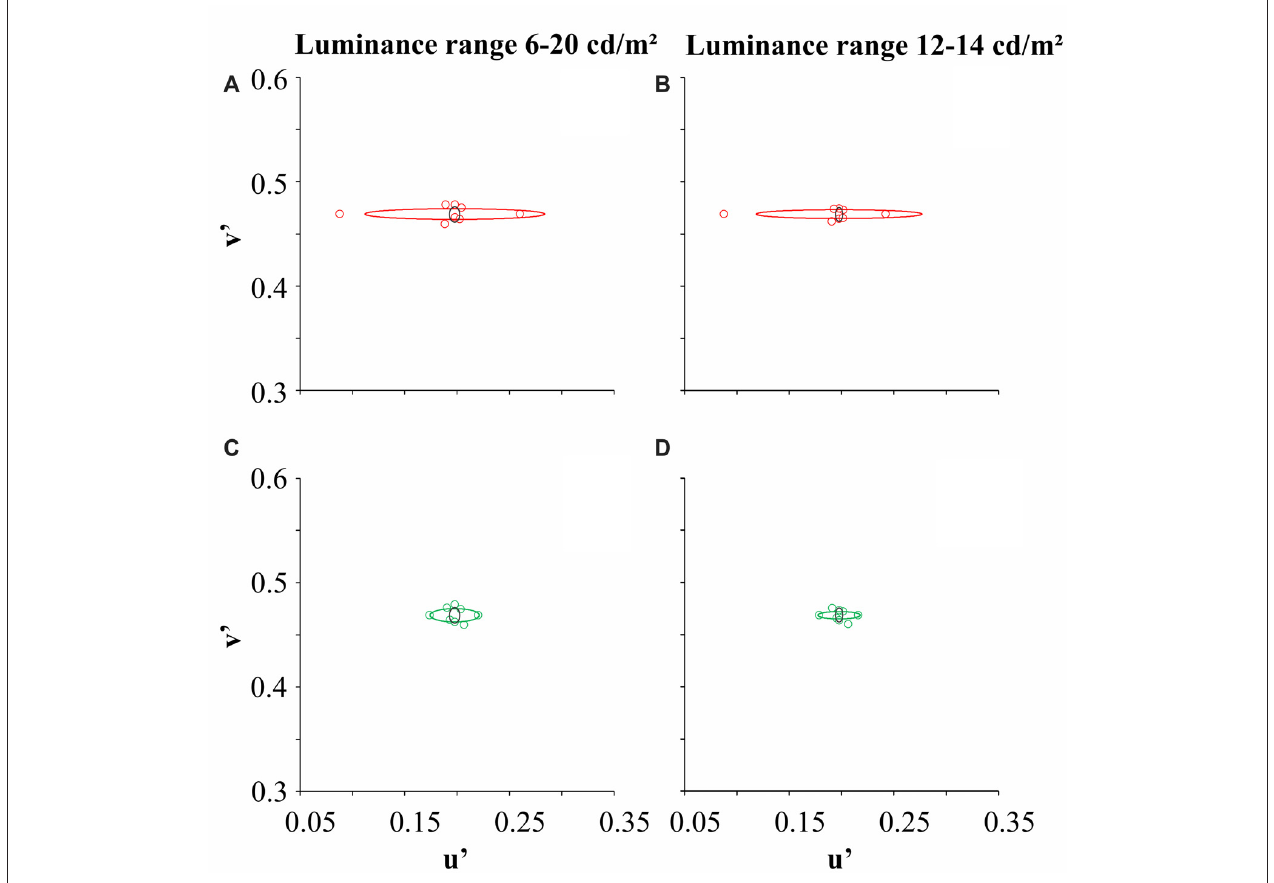
FIGURE 3 | Color discrimination ellipses for one trichromat (black ellipse), one protan subject (red ellipse) and one deutan subject (green circle). Panels (A,C) represent color discrimination in the luminance noise amplitude of 14 cd/m 2 , while (B,D) represent color discrimination in the luminance noise amplitude of 2 cd/m 2 . Circles represent the threshold coordinates for the protanope (red circles) and deuteranope (green circles).